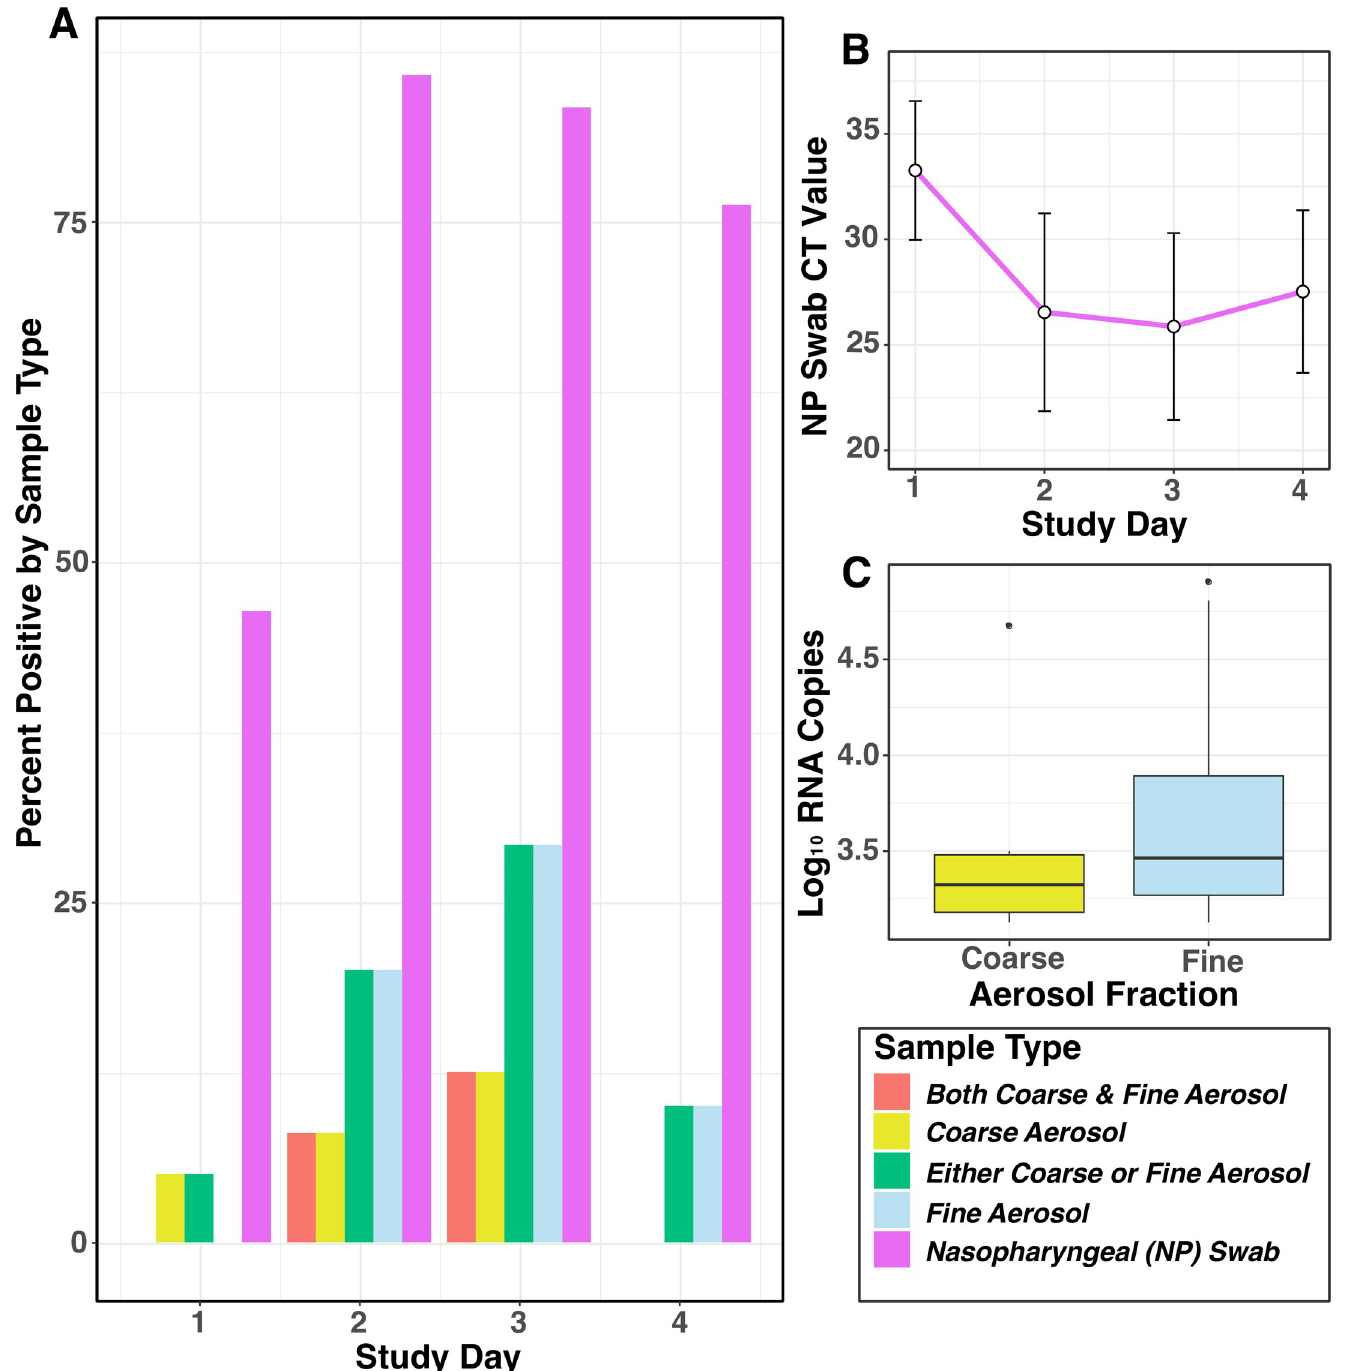
Fig 3. Viral detection in Donors by day of exposure event. A) Columns show the proportion of all infected donors (n = 42) who were qRT-PCR positive for viral shedding for coarse ( > 5 μ m) and fine ( � 5 μ m) aerosols, and nasopharyngeal swabs. B) Mean and standard deviation error bars for qRT-PCR cycle threshold values from the positive nasopharyngeal swabs (n = 19 on day 1; n = 34 on day 2; n = 35 on day 3; n = 31 on day 4). C) Virus quantified (log 10 RNA copies) from detectable exhaled coarse (n = 6) and fine (n = 14) breath aerosols by qRT-PCR; the boxes show the inner-quartile range (IQR) with a band to indicate the median, and whiskers extending to highest and lowest data points within 1.5